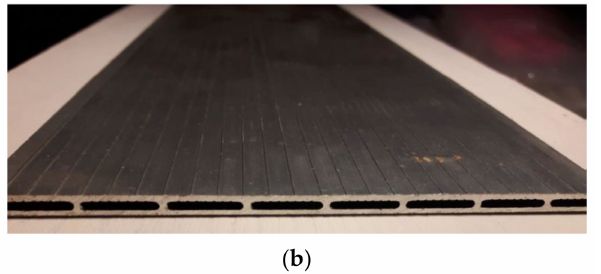
Figure 2. ( a ) Fabricated microchannel (MC) heat exchanger; ( b ) Cross-section of the MC heat exchanger element.